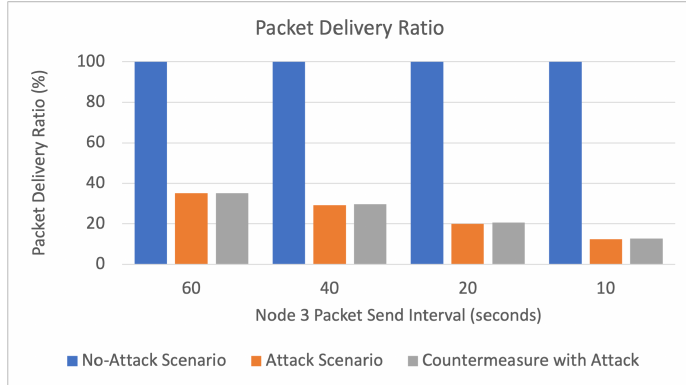
Figure 16. Packet drop ratio.